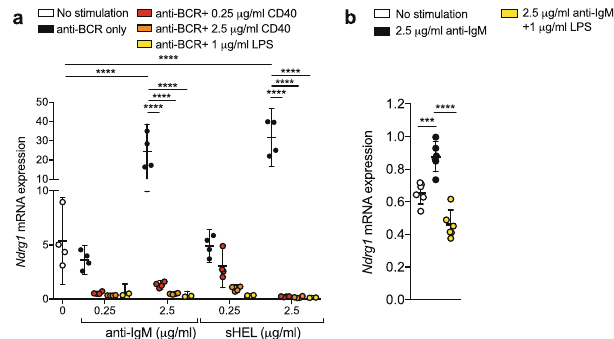
Fig. 2 Ndrg1 expression is regulated by the signal one/signal two axis in B cells. a Ndrg1 mRNA expression calculated relative to Gapdh expression in Ig HEL primary B lymphocytes stimulated ex vivo with the indicated concentrations of anti-IgM or sHEL, with or without anti-CD40 or LPS for 24 h at 37 °C. b Ndrg1 mRNA expression calculated relative to Gapdh expression in murine A20 Ig HEL tg B cells cultured for 24 h at 37 °C with anti-IgM and with or without LPS. Lines show means with 95% con fi dence interval (CI) error bars. Data presented are from two to four replicate qPCR readings for each condition and is representative of 3 independent experiments using Ig HEL or non-tg ( a ) or pooled from two A20 ( b ) independent experiments. Signi fi cance was determined using a two-way ANOVA with post-hoc Tukey ’ s testing, *** p < 0.001 and **** p < undetectable by transitional western blot, however knockout was con fi rmed by immunoblot analysis of WT and Ndrg1 − / − in kidney lysates using a N-terminal binding antibody (Supple- mentary Fig. 1e). In splenic lysates, immunoprecipitation and blotting con fi rmed the complete loss of NDRG1 protein expres-